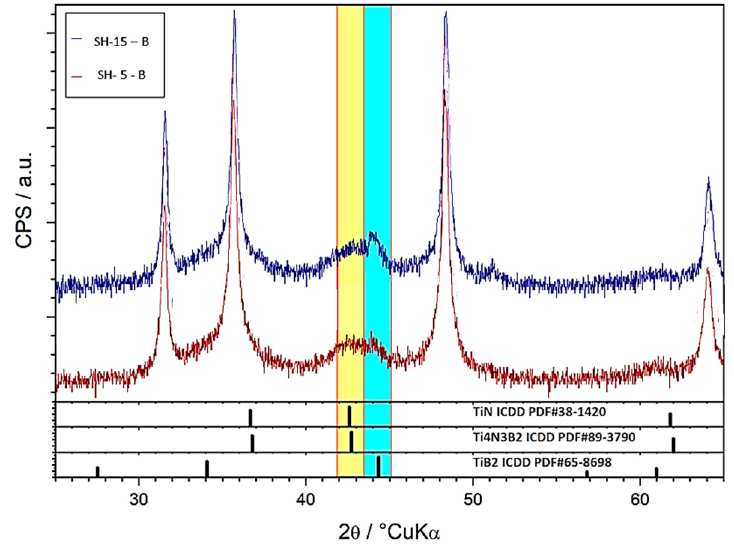
Figure 20. XRD pattern of coated sample: SH-5-TiBN and SH-15-TiBN.